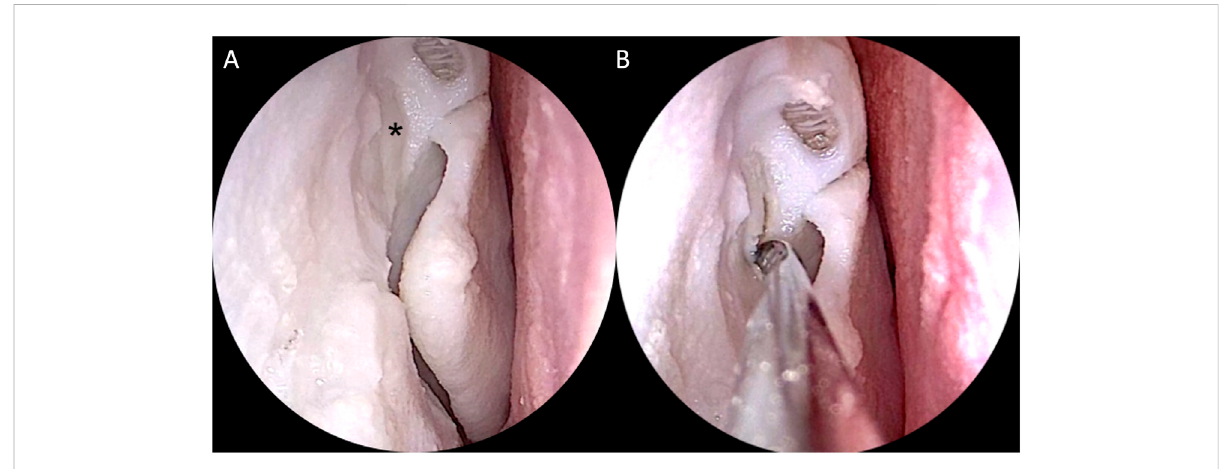
FIGURE 13 Simulation of right endoscopic dacryocystorhinostomy. (A) Exposure of the lacrimal sac (black asterisk); (B) Incision of the sac with the sickle